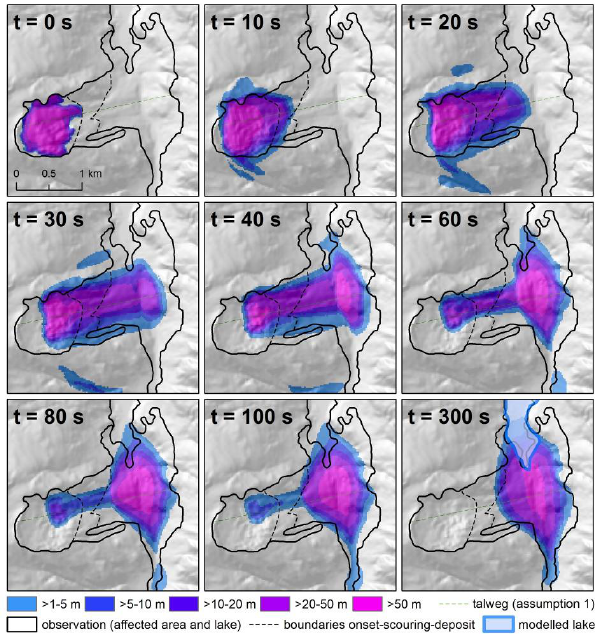
Fig. 7: Time series of flow velocity distribution simulated with φ = 35° and δ = 22° at a cell Fig. 7. Time series of flow velocity distribution simulated with φ = size of 20 m. 35 ◦ and δ = 22 ◦ at a cell size of